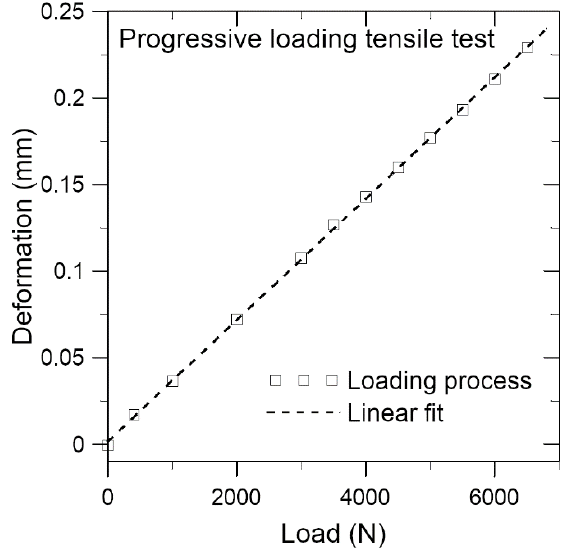
Figure 6. Specimen elongation versus maximum load for each progressive loading cycle.